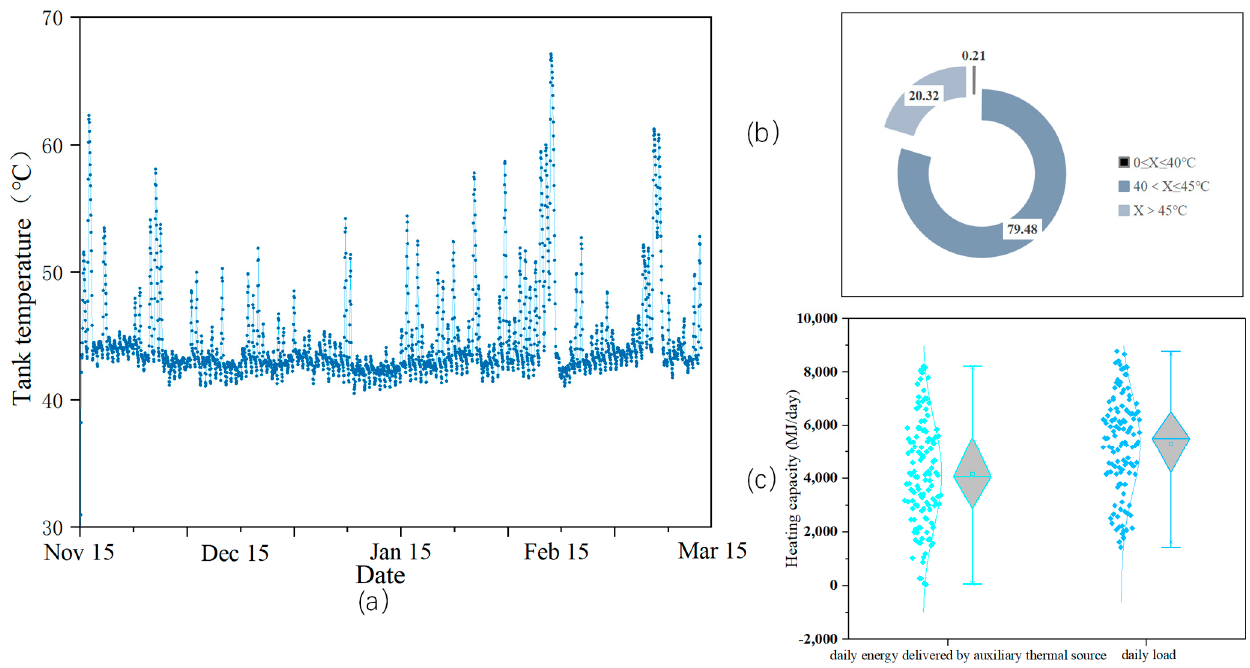
Figure 4. ( a ) Hourly change curve of the temperature of the HSWT; ( b ) the proportion of the temperature of the HSWT; ( c ) statistic of the daily heat supply of the AHS and the daily load of the building.